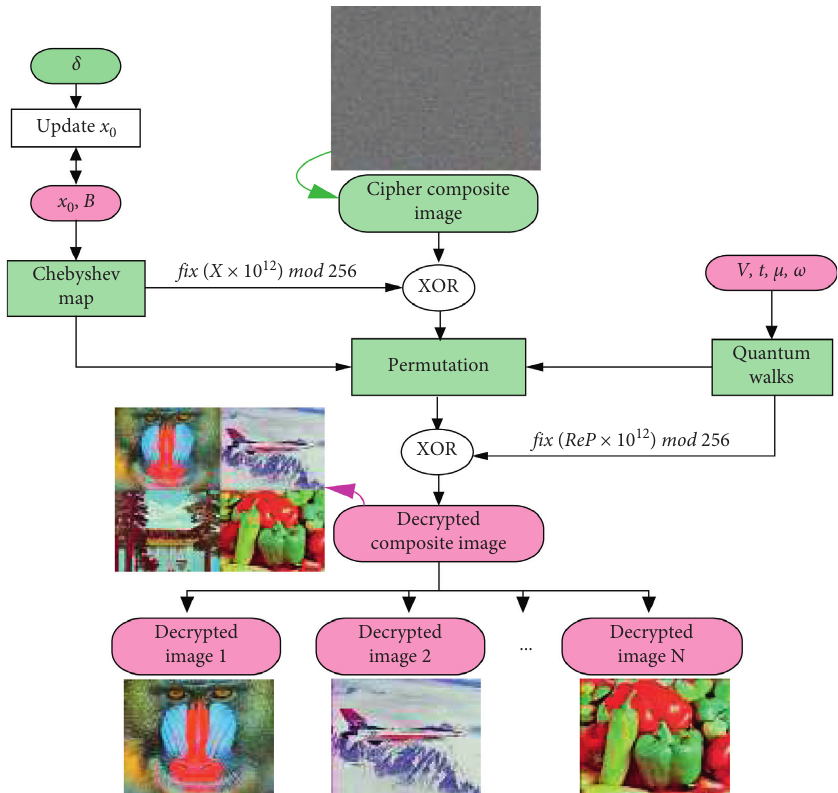
Figure 2: Structure of the decryption procedure for the proposed multiple-image